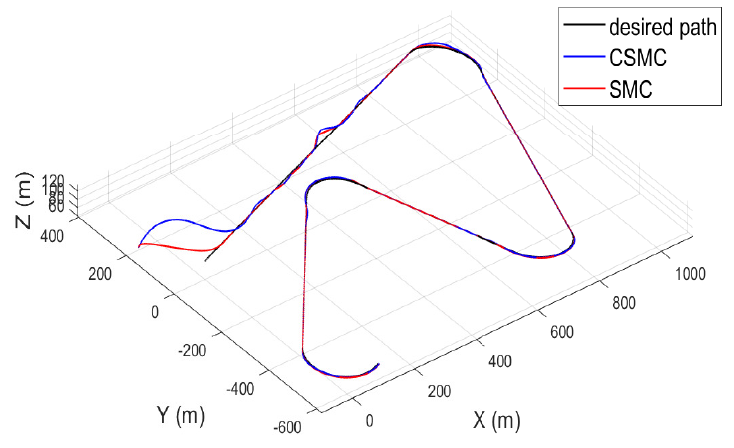
Figure 6. Tracking lines of the UAVs controlled by means of SMC and CSMC, respectively.